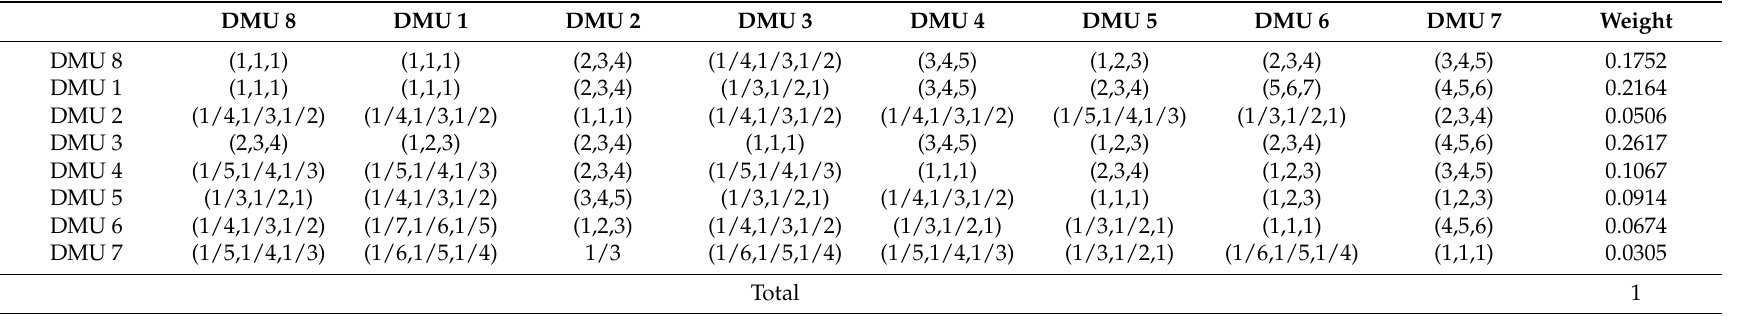
Table A22. Comparison matrix for COC based on alternatives.